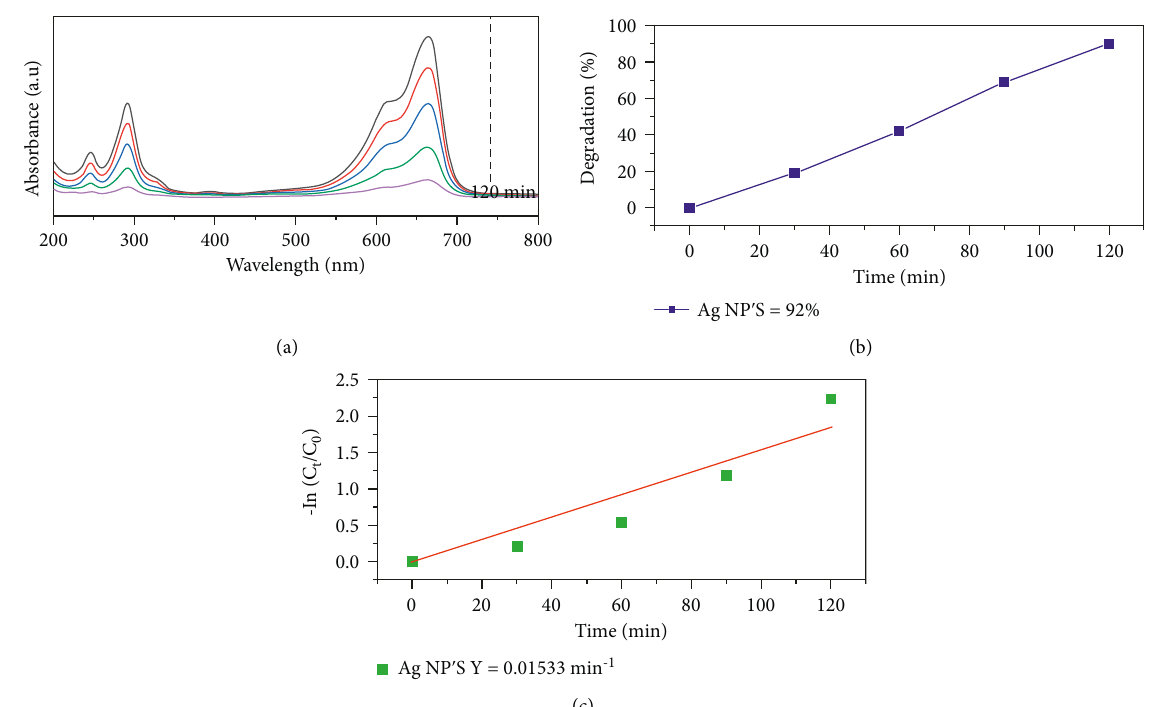
Figure 9: (a) Time-dependent UV-Vis absorbance spectra of MB dye degradation, (b) degradation efficiency, and (c) pseudo-first-order